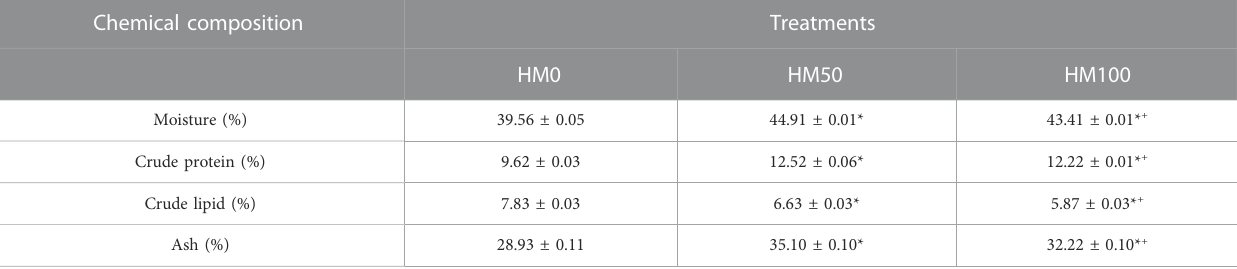
TABLE 4 Whole body composition (g/100 g fresh material) of juvenile P. leptodactylus individuals fed with three different diets with H. illucens meal substitution. Chemical